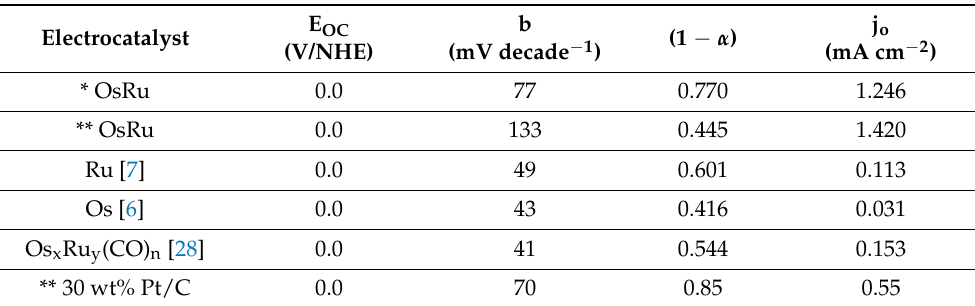
Table 4. Open circuit potential and electrokinetic parameters of the OsRu electrocatalyst for the hydrogen oxidation reaction (HOR) in 0.5 mol L − 1 H 2 SO 4 , compared with similar materials reported in the literature and with 30 wt% Pt/Vulcan XC-72.